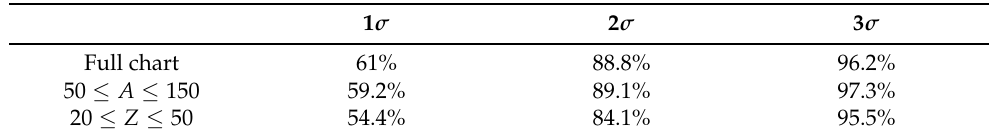
Table 1. Percentage of nuclei included in the total error bars for the DZ10-GP model for three different sectors of the nuclear chart. 1 σ 2 σ 3 σ Full chart 61%